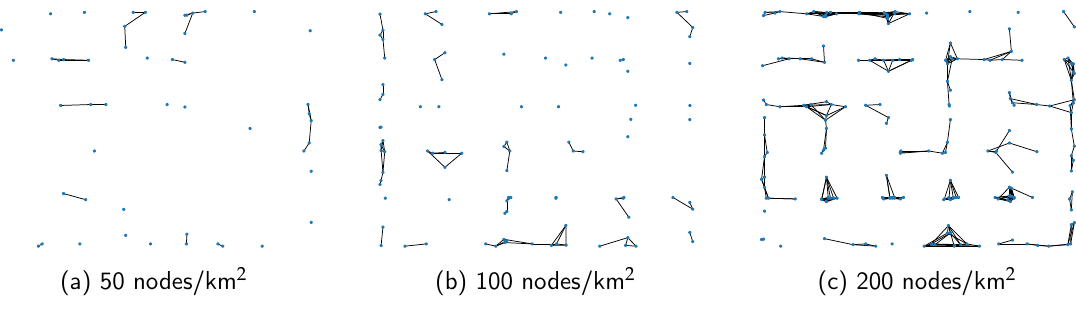
Figure 3. Network connectivity with different node densities. Table 2. Simulation